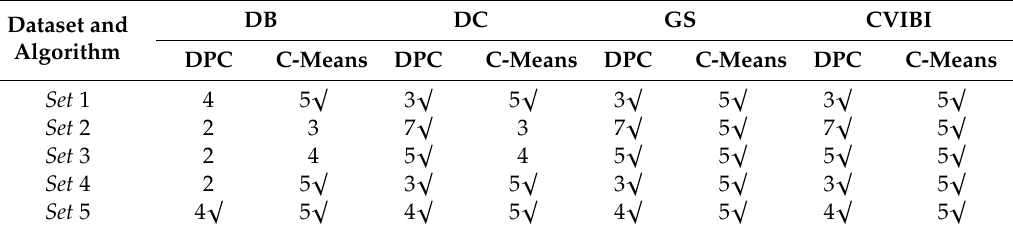
Figure 16. Tests of CVIBI on CT images with DPC. Table 4. Evaluation of clustering results by CVIBI, DB, DC and GS for 15